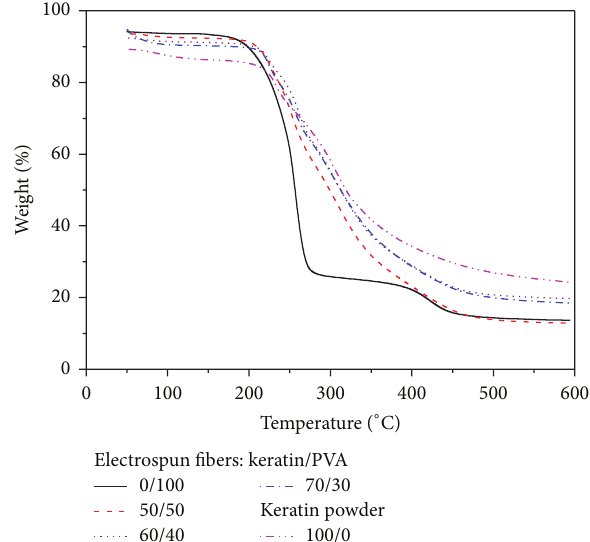
Figure 7: TGA data of electrospun PVA, keratin powder, and the blend nanofibers obtained using various weight ratios of keratin to PVA.